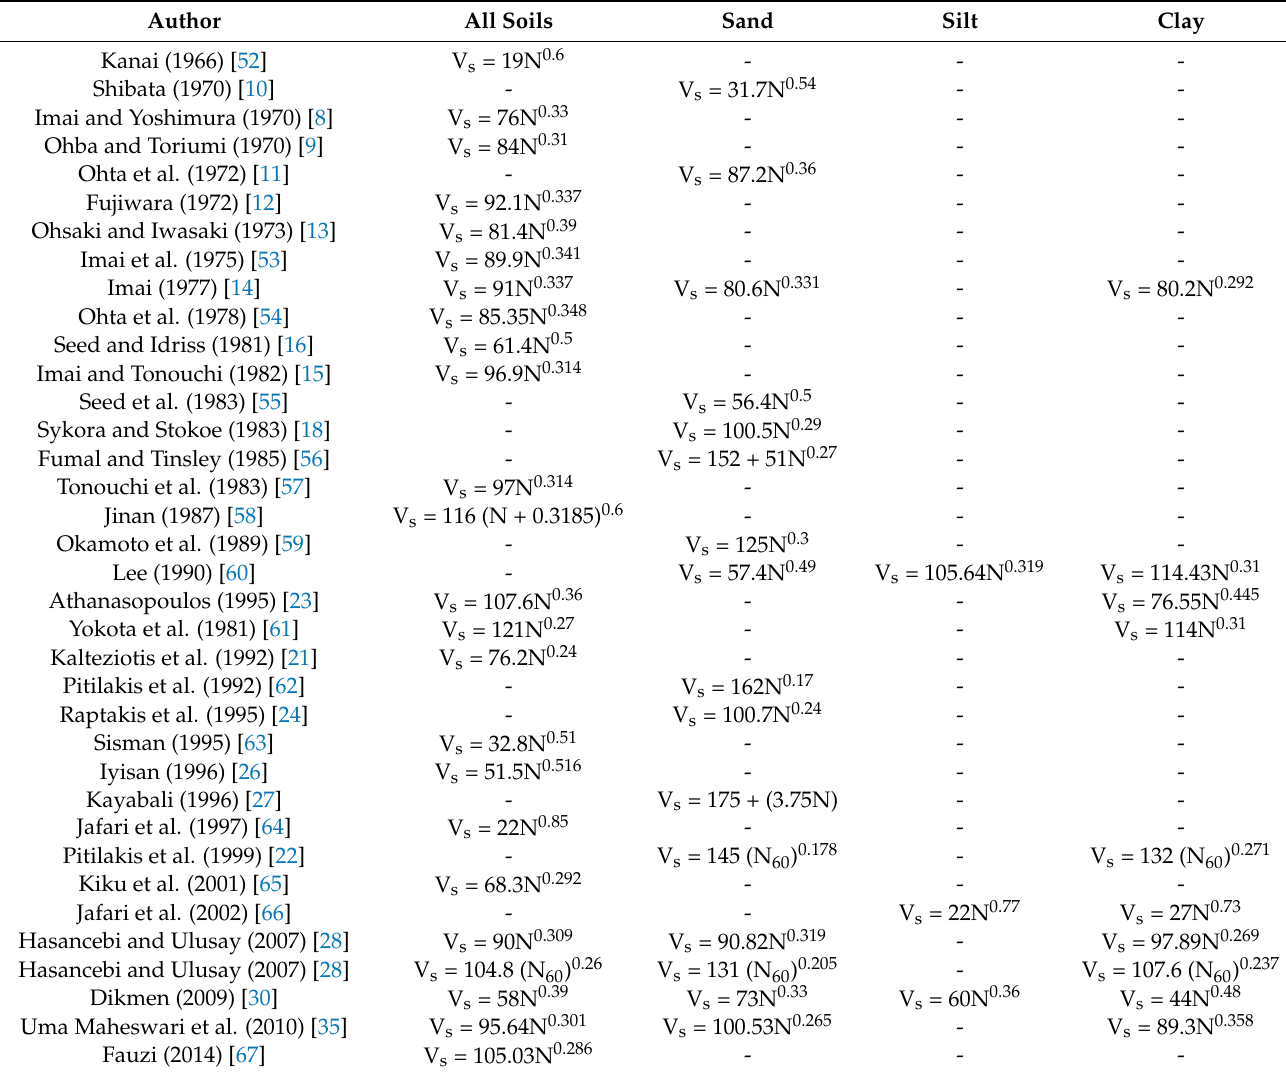
Table 2. Existing correlation between shear wave velocity and standard penetration